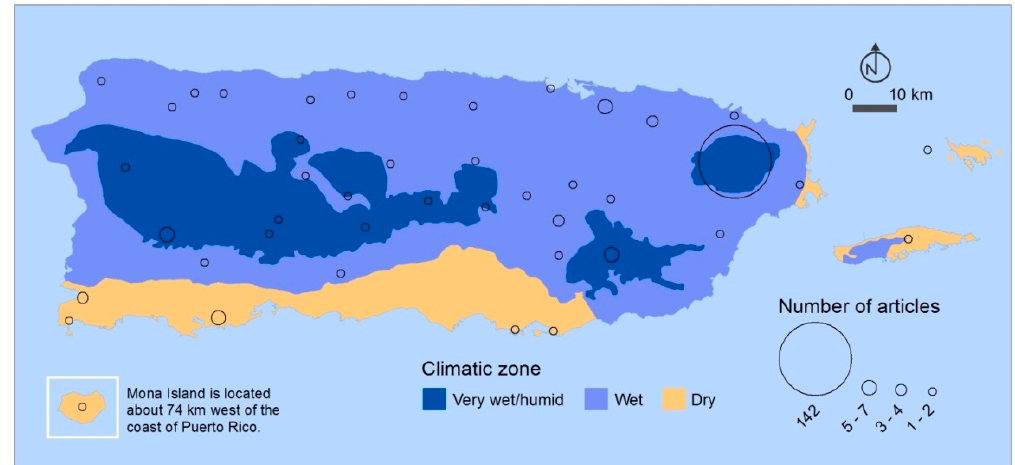
Figure 6. Location of study sites with number of articles published in relation to climatic zones.